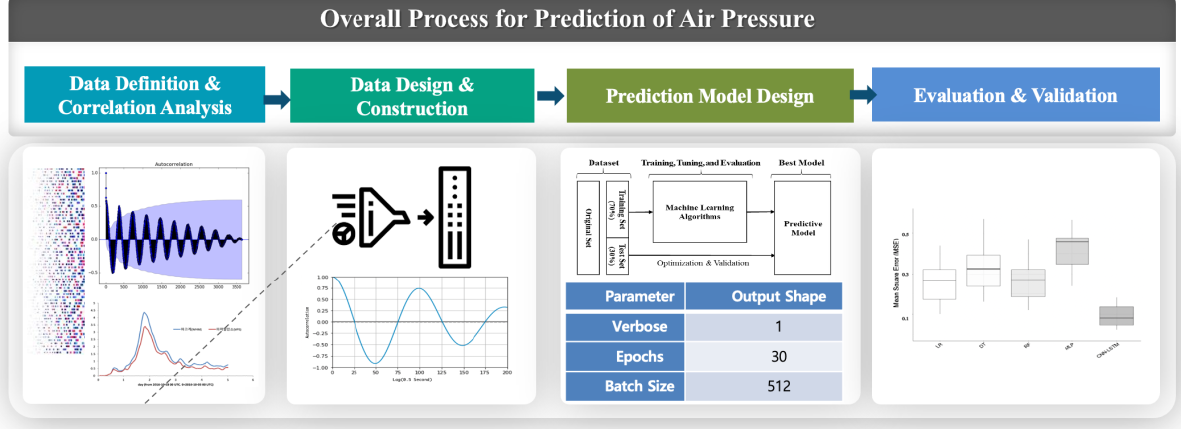
Figure 3. Process of the pressure prediction model based on machine-learning in OWC–WEC.